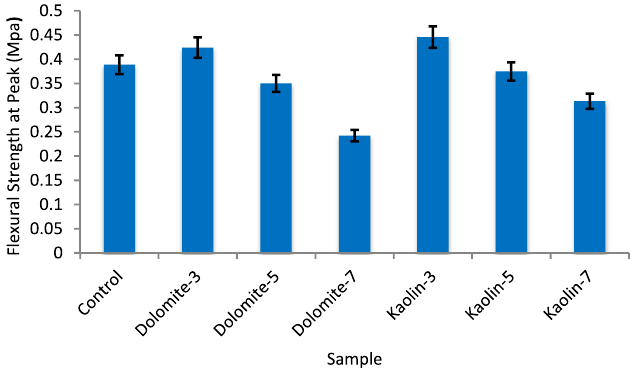
Fig. 8. Flexural strength at peak of the dolomite and kaoline fi lled polyurethane foam.